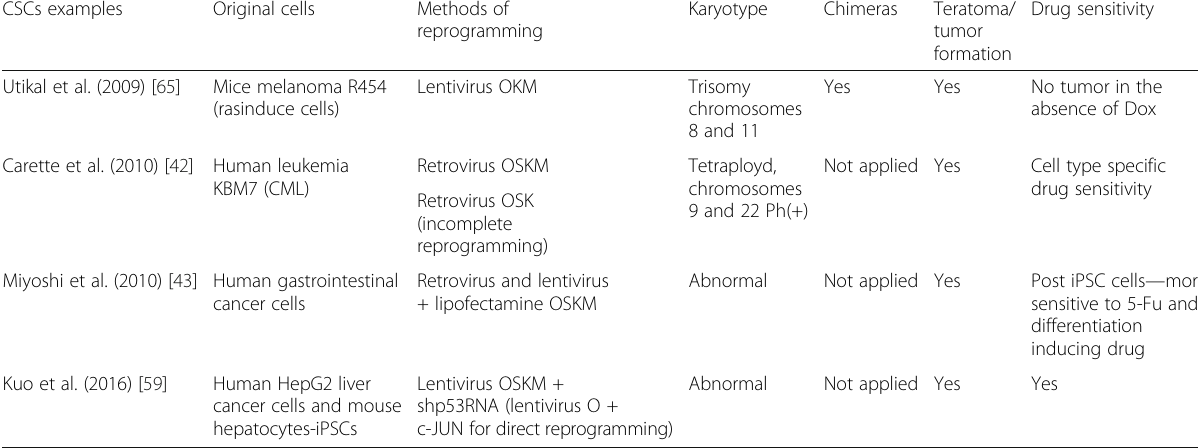
Table 1 Summary of studies of reprogramming of cancer cells from induce pluripotent stem cell technology. We have modified the summary of the table reported by Camare et al. [25,